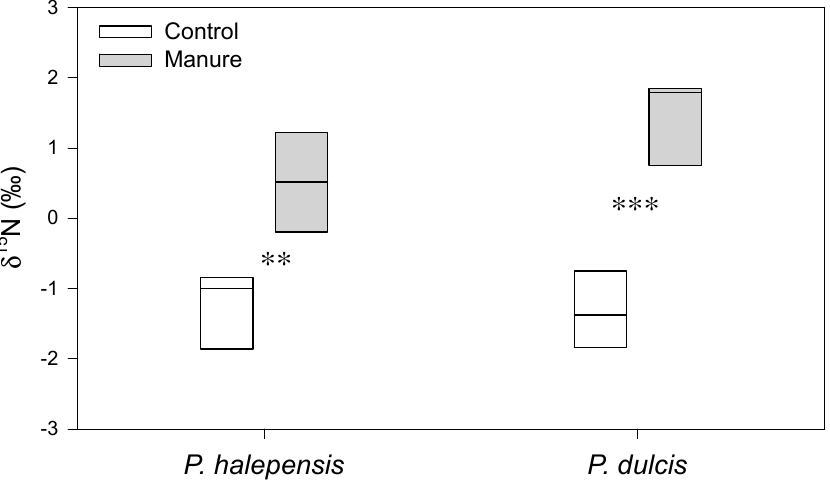
Figure 4. Values of δ 15 N in tree-ring wood of control (empty bars) and manure-applied (grey bars) trees of the two study species. The asterisks indicate significant differences between the two groups of trees in each species according to Dunn tests ( P. halepensis , ** p < 0.01; P. dulcis , *** p < 0.001).